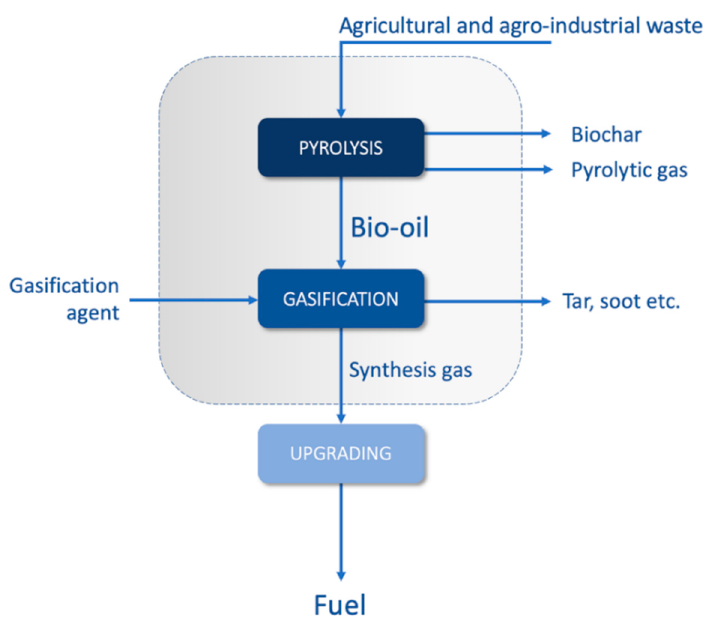
Figure 2. Thermochemical module including pyrolysis and gasification.